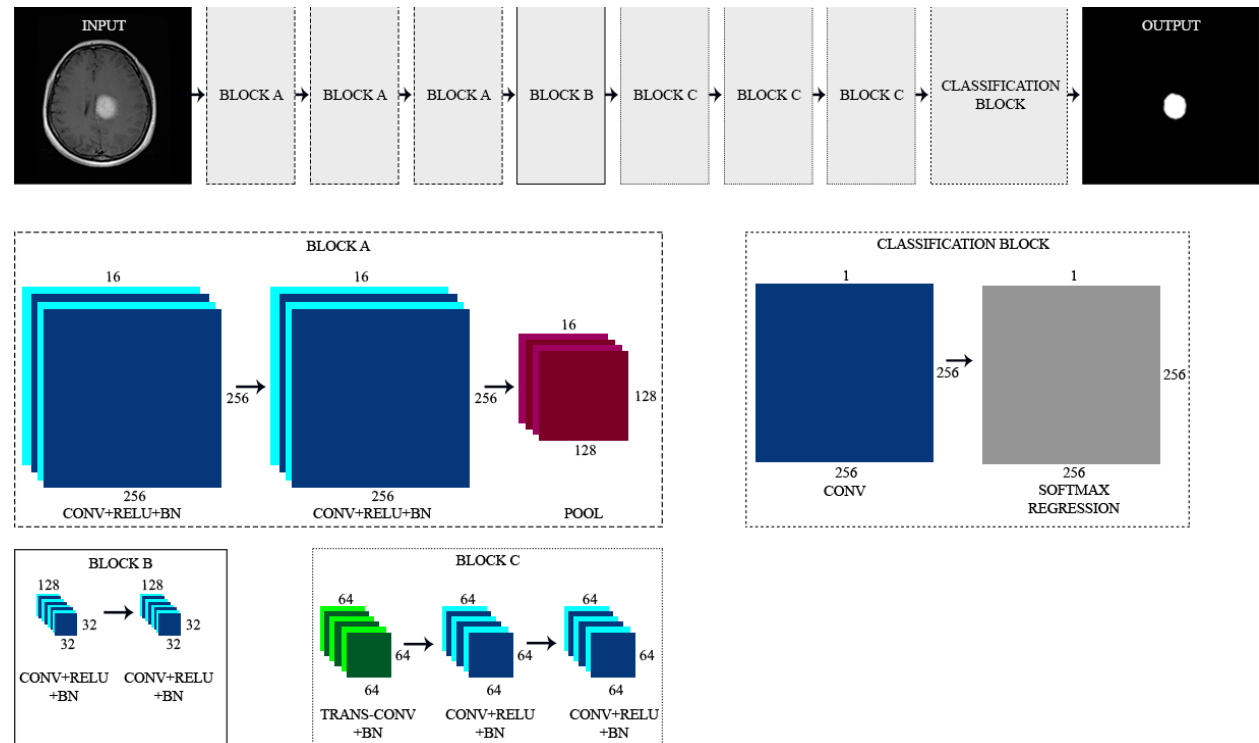
Figure 2. Schematic representation of the CNA segmentation architecture containing the input layer, three Blocks A, Block B, three Blocks C, Classification Block, and Output Layer. Block A represents the encoder, Block C the decoder. Conv layers retain the input dimensions at the output, and Pool and Trans-Conv reduce, i.e., increase the output size. CONV — convolutional layer; RELU — rectified linear unit activation function; BN — Batch Normalization, POOL — association layer; TRANS-CONV — transposed convolutional layer; SOFTMAX — softmax activation layer. Table 1. New CNA architecture for brain tumor segmentation. All network layers are listed along with their parameters. Layer No Layer